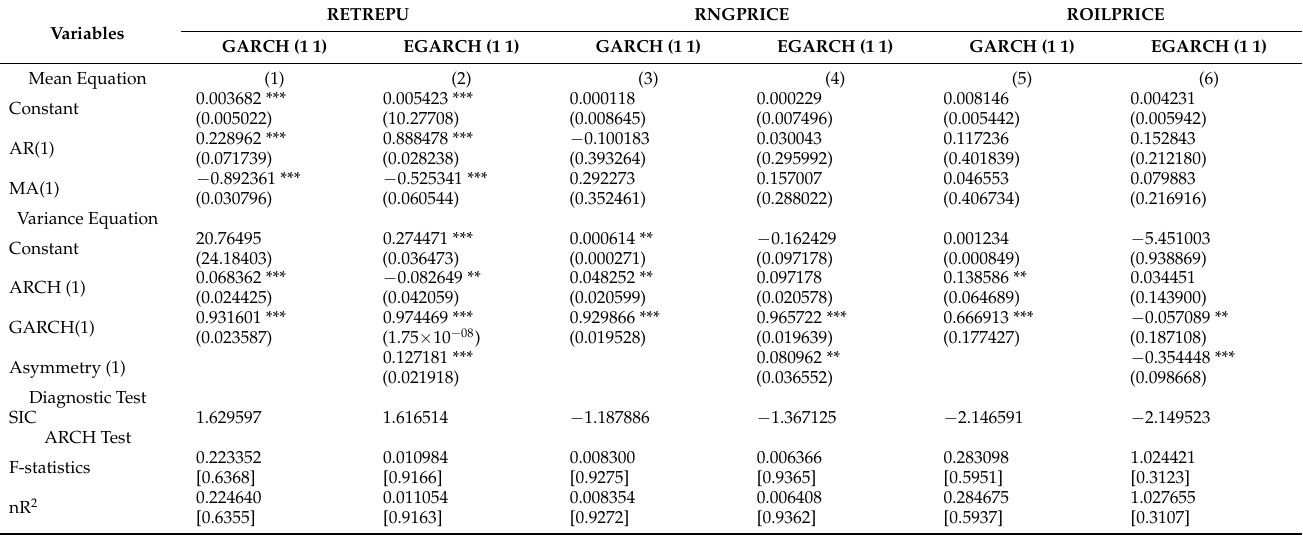
Table 3. Estimates of univariate GARCH